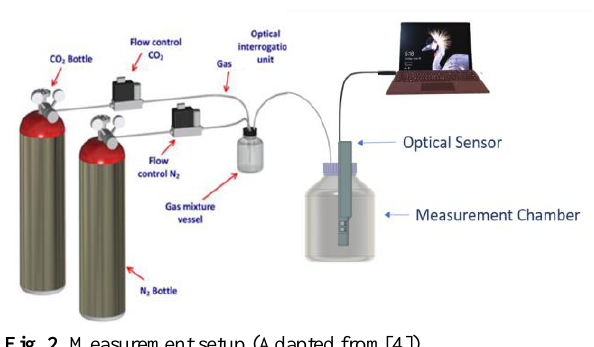
Fig. 2. Measurement setup (Adapted from[4])